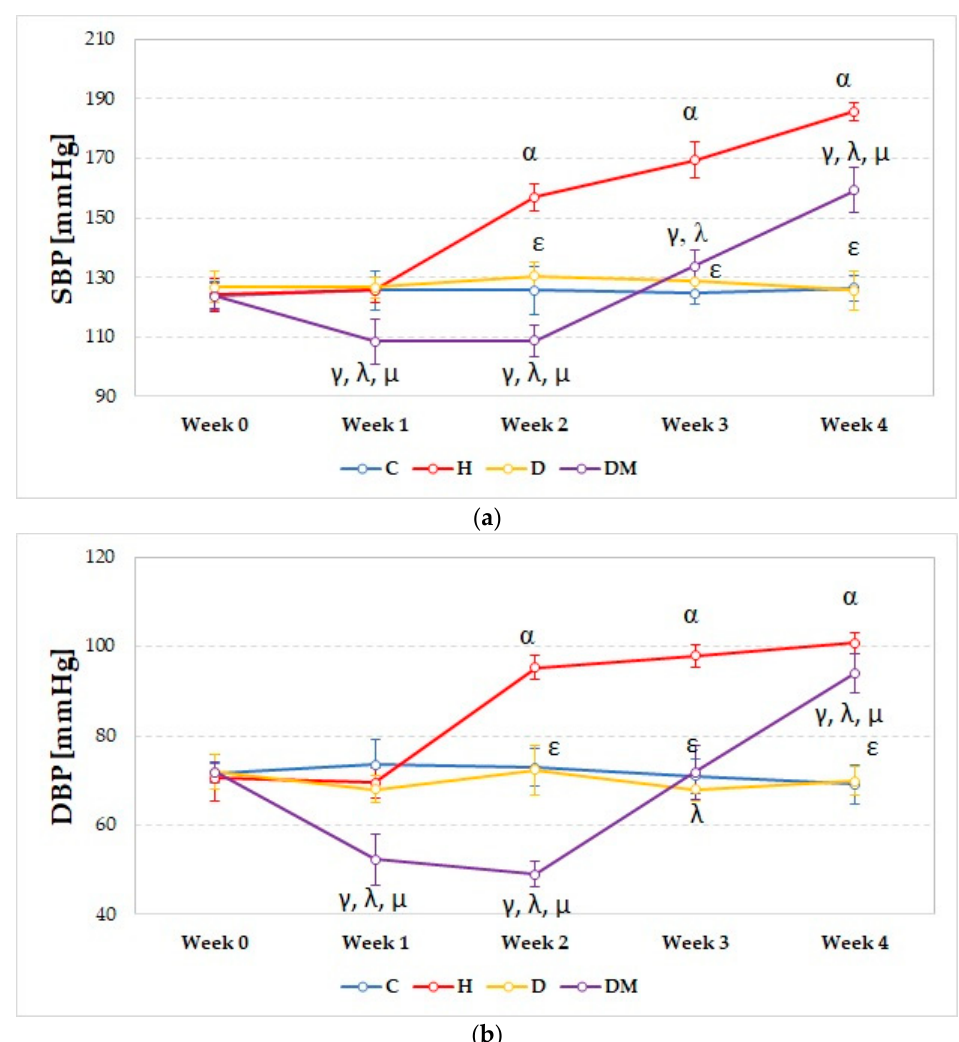
Figure 2. Evolution of: ( a ) Systolic blood pressure (SBP); ( b ) Diastolic blood pressure (SBP); Circles represent the median of each group. C = Control group, H = Hypertension group, D = Dyslipidemia group, DM = Type 1 Diabetes Mellitus group. The letter codes correspond to the p -values: < 0.035, α H compared to C, < 0.018, γ DM compared to C, < 0.016, ε D compared to H, < 0.035, λ DM compared to H, < 0.009, µ DM compared to D.